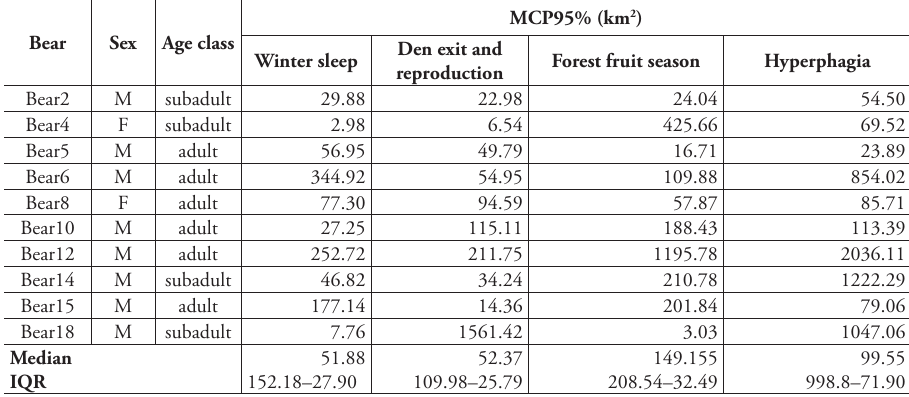
Table 2. Brown bears MCP95% seasonal home range sizes in Eastern Romanian Carpathians and Sub- carpathians (M = males, F =